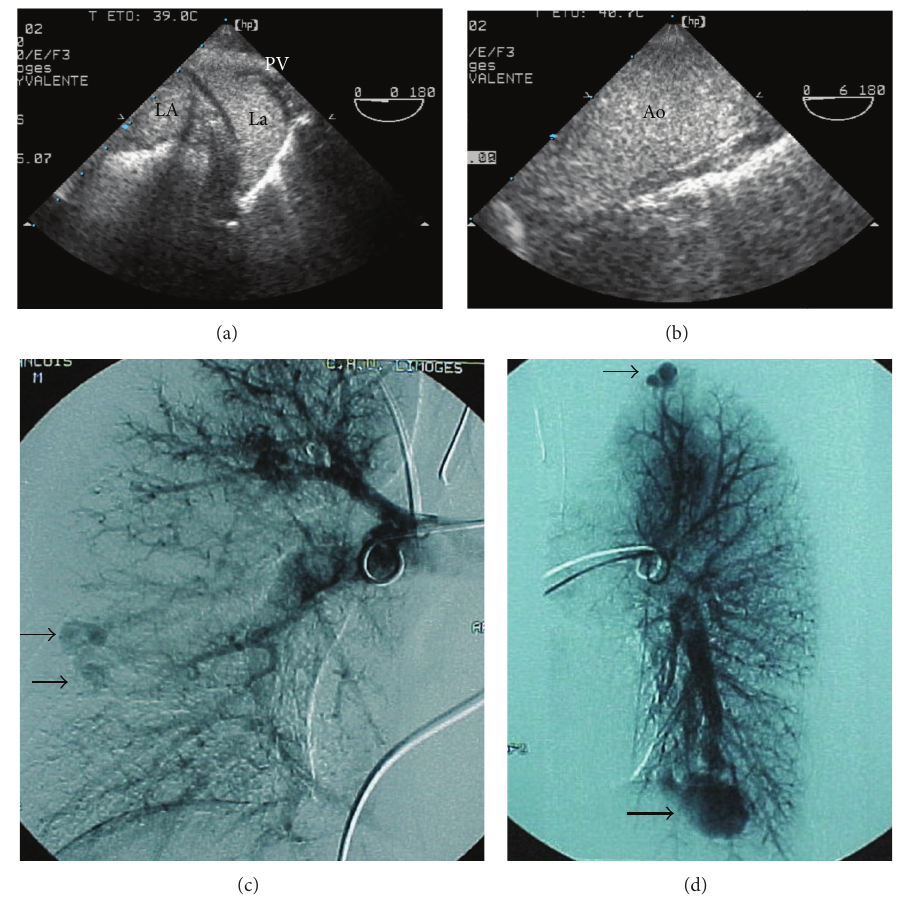
Figure 1: Pulmonary arteriovenous fistulae associated with the Rendu-Osler-Weber disease. The contrast study performed during a transesophageal echocardiographic examination depicted a massive opacification of the left atrium a few beats after the opacification of the right atrium through the left and right pulmonary veins (a), but no patent foramen ovale, and a subsequent massive opacification of the aortic arch (b). Pulmonary angiography confirmed the presence of multiple arteriovenous fistulae in the two lungs ((c) and (d), arrows), the largest being located in the left inferior lobe (thick arrow). These lesions were subsequently excluded from the pulmonary circulation by serial percutaneous transcatheter embolizations. LA: left atrium; La: left atrial appendage; PV: pulmonary vein; Ao: aortic